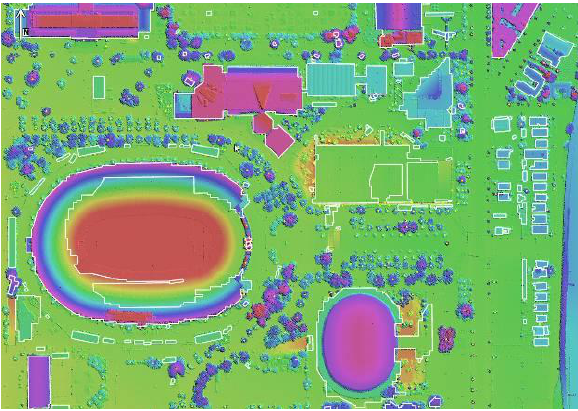
Figure 11. AFE cannot extract the football stadium and the track field